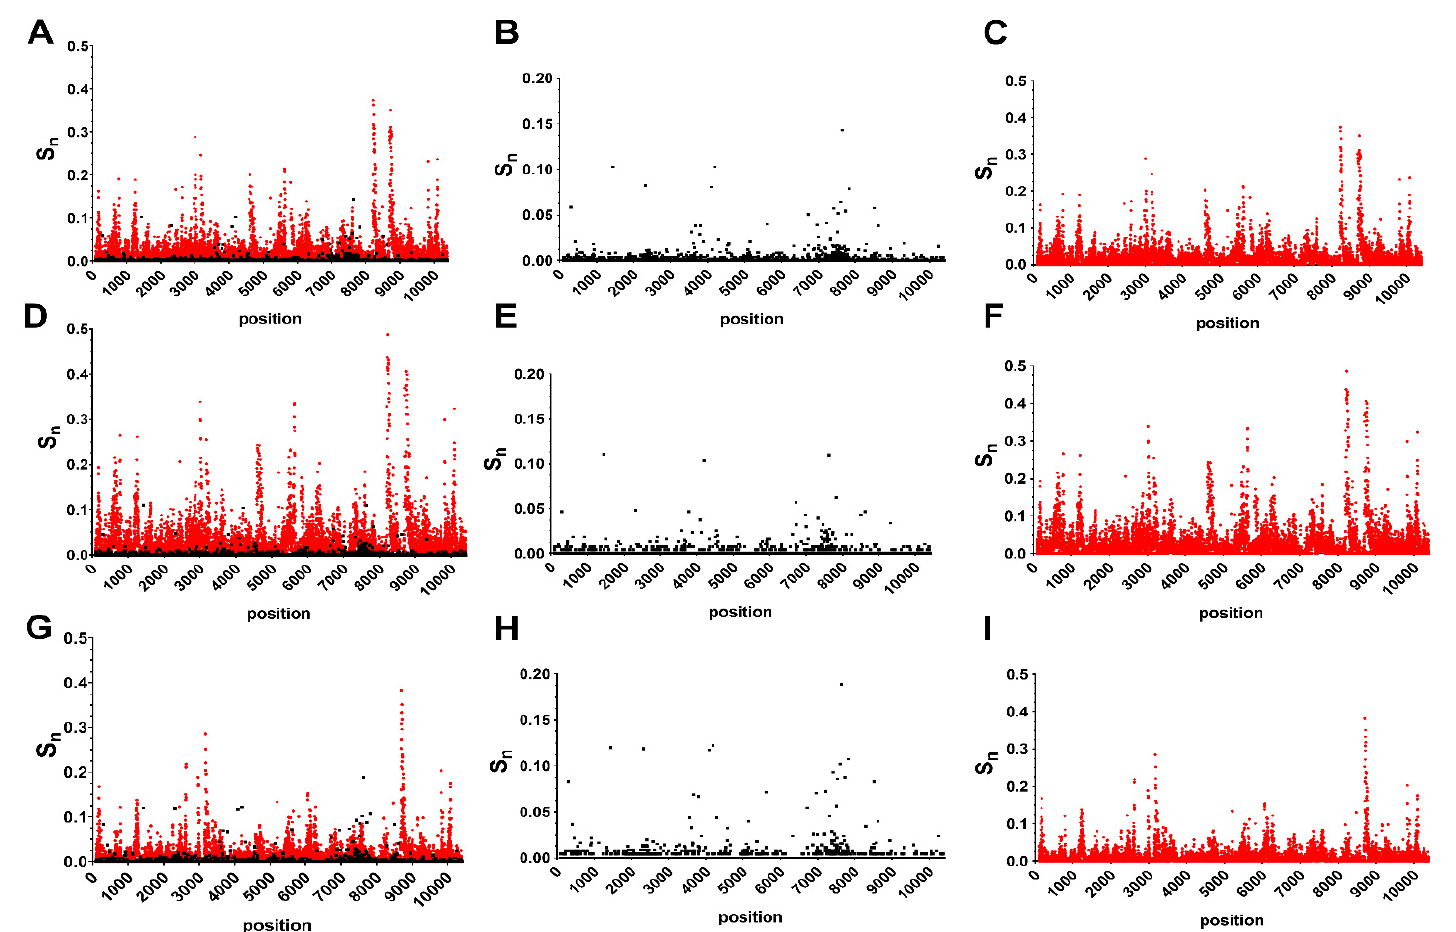
Figure 2. Unique amino acid (AA) landscapes of West Nile virus identified in consensus and minority sequences. AA entropy (Sn) in all hosts ( A – C ), avian hosts ( D – F ) and mosquito hosts ( G – I ) is shown at each position in the genome. Interhost AA diversity is shown in panels B, E, and H while intrahost diversity is shown in panels C, F, and I.